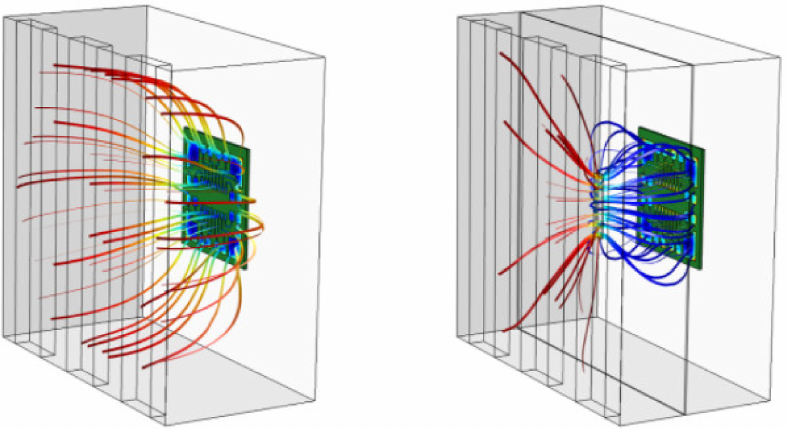
Figure 2. Distribution pattern of electric force fields in a galvanic bath with an aperture of various configurations. The colors of the lines are showing the level of field strength. The shape of the lines is illustrating the distribution of field in a galvanic